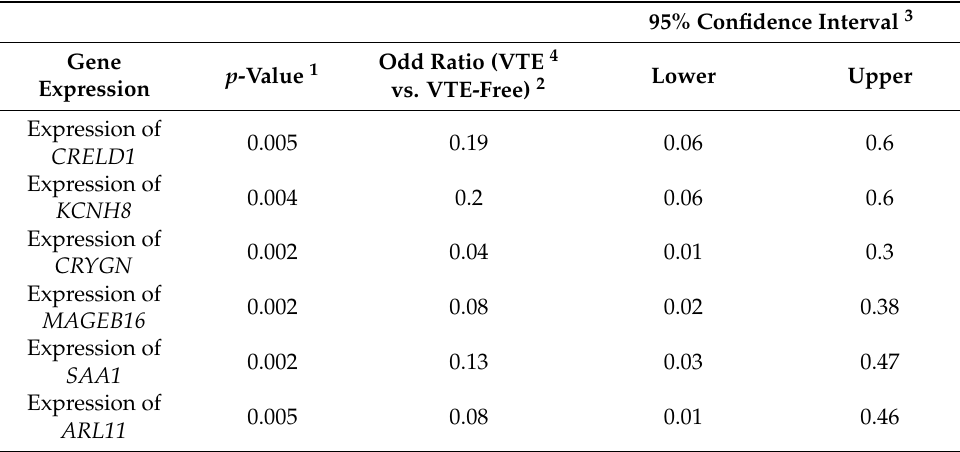
genes in patients with VTE correlated significantly with elevated thrombotic risk as their expression increased (odd ratios VTE vs VTE-free > 1; p -value < 0.05). Table 4 displays the p -value and odd ratios with respect to expression and thrombotic risk in the overall cohort for the logistic regression of each gene, in addition to the confidence interval of odd ratios. Figure 2 compares the odd ratios of the regressions carried out for each gene. Table 4. Results of the conditional logistic regression by histopathological